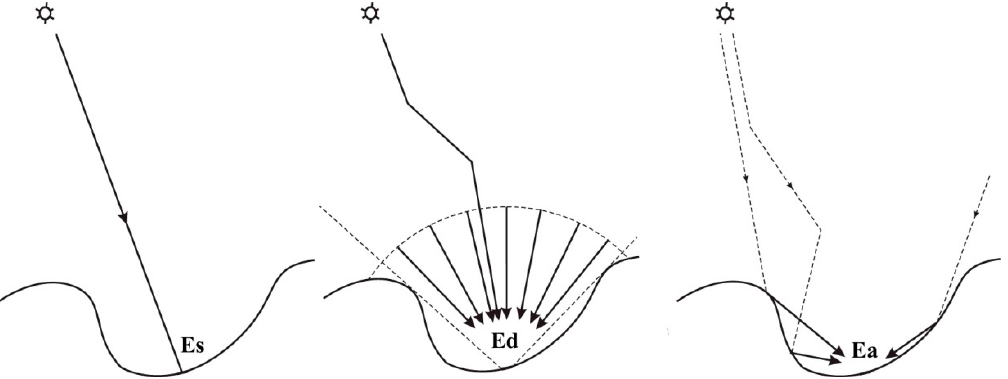
Figure 7. Irradiance at the land surface.